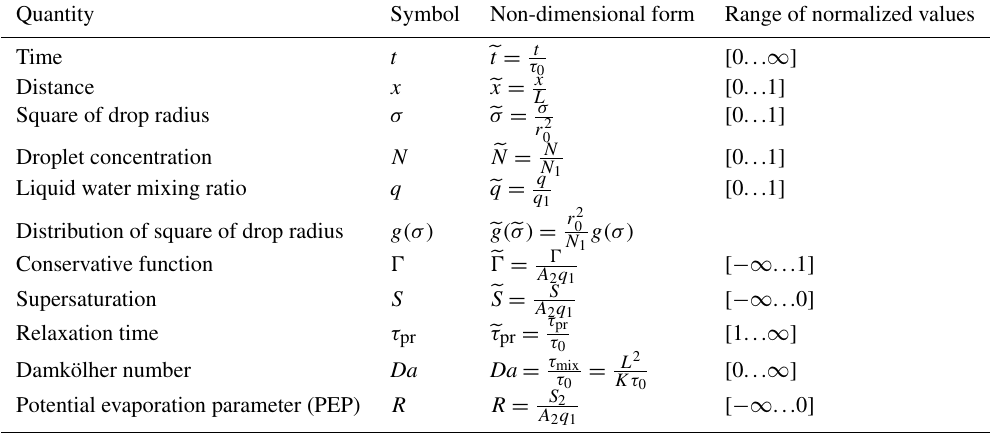
Table 1. Main parameters of the problem and their non-dimensional forms ∗ . Quantity Symbol Non-dimensional form Range of normalized values Time t Distance x Square of drop radius σ Droplet concentration Liquid water mixing ratio Distribution of square of drop radius Conservative function Supersaturation Relaxation time Damkölher number Potential evaporation parameter (PEP)